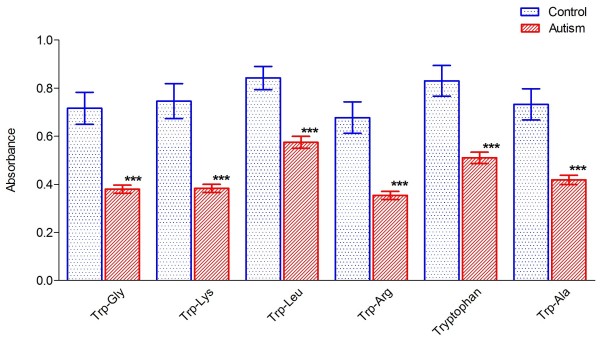
Histogram of energy metabolism in the ASD cells vs. control cells. The bar height of the histogram indicates the mean of measurements of 50 cell lines for each group; vertical bars are standard errors of the means. Star symbol (*) denotes level of statistical significance determined by a t test: ***P <0.001. The substrates were ordered according to their individual P values with the lowest on the left.